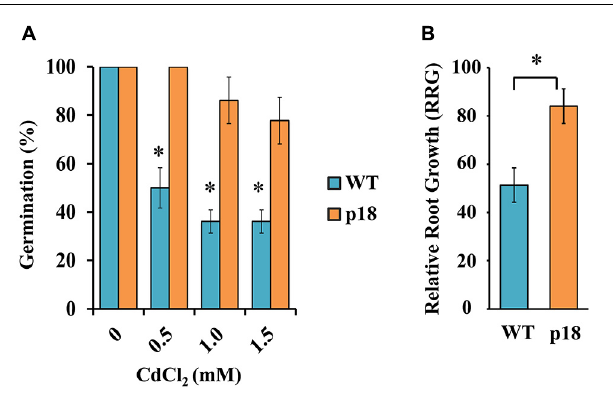
FIGURE 1 | Effects of cadmium on germination and seedling relative root growth of M. truncatula WT and p18 lines. (A) Germination percentage of M. truncatula WT and transgenic p18 seeds at different CdCl 2 concentrations for 7 days. ∗ Indicates significant differences between control and Cd treatment (Chi-squared ( χ 2 ), p < 0.05, n = 3 replicates per treatment, each containing 12 seeds). (B) Relative root growth (RRG) of M. truncatula WT and transgenic p18 seedlings in the presence of Cd (40 µ M CdCl 2 , 48 h). ∗ Indicates significant differences between genotypes, one-way ANOVA, p < 0.05, n = 10. Bars indicate standard